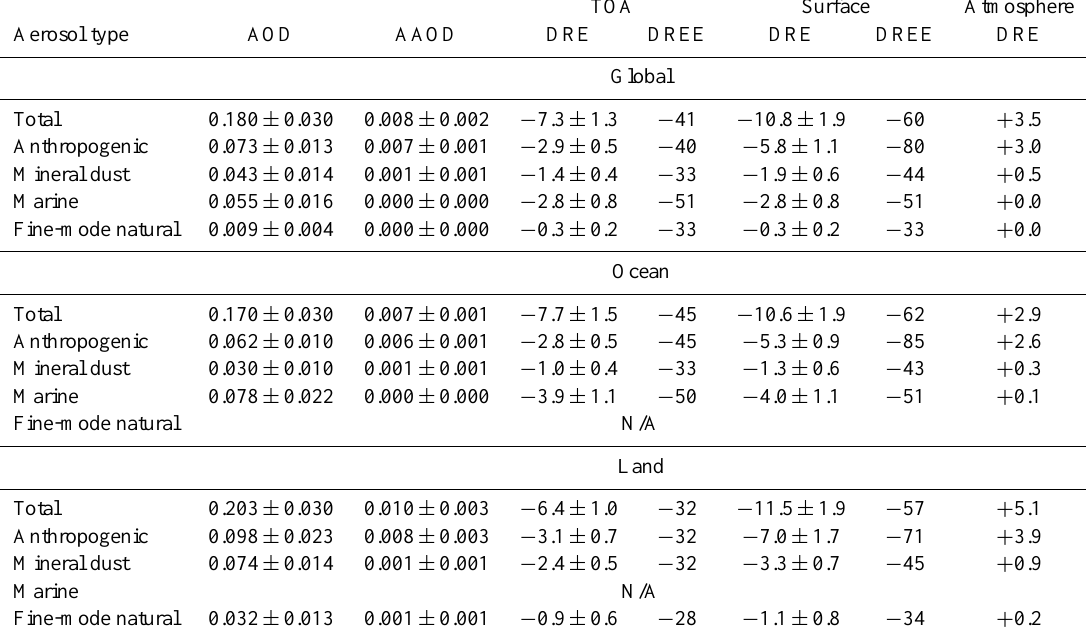
Table 2. Total and component aerosol optical depths (AOD), absorption aerosol optical depths (AAOD), direct radiative effects (DRE), and direct radiative effect efficiencies (DREE), for the MACC re-analysis over the period 2003–2010, in global, ocean, and land averages. Optical depths are given at 0.55µm. Direct effects, in Wm − 2 , and efficiencies, in Wm − 2 per unit AOD, are for the shortwave spectrum and cloud-free conditions, and given at the top of atmosphere (TOA), surface, and within the atmosphere. See Sect. 7 for calculation of